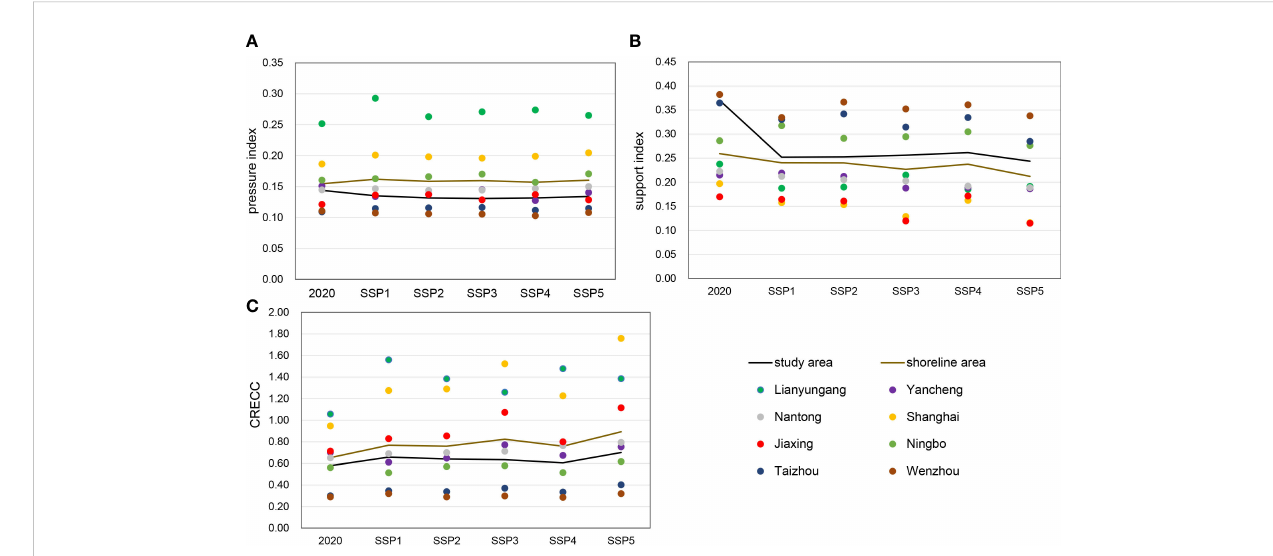
FIGURE 5 Changes of pressure index (A) , support index (B) and CRECC (C) of 8 cities along the shoreline from 2020 to 2050.